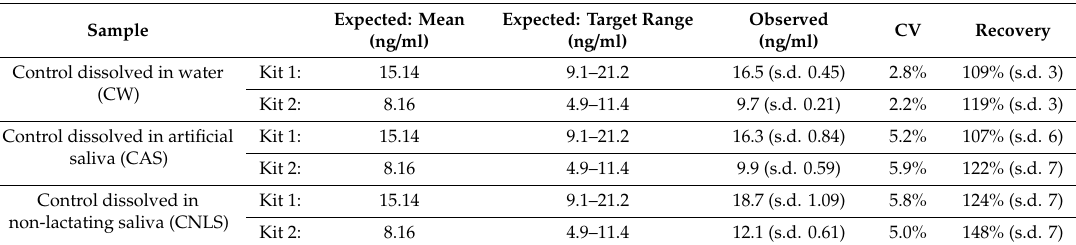
Table 1. Expected and observed prolactin values when control was dissolved in water (CW), artificial saliva (CAS), and non-lactating saliva (CNLS). Mean and standard deviation for the observed values and recovery percentage.